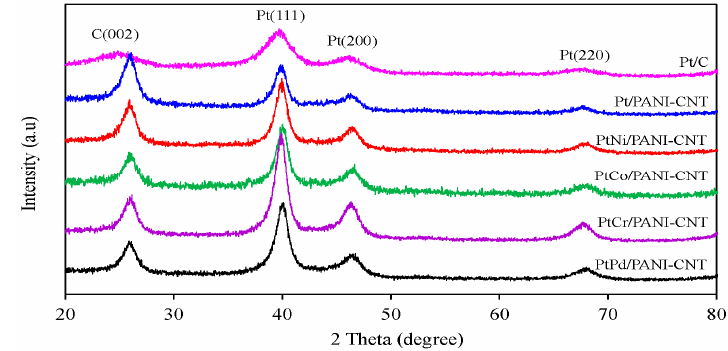
Figure 2. Representative of XRD patterns of the different catalysts.